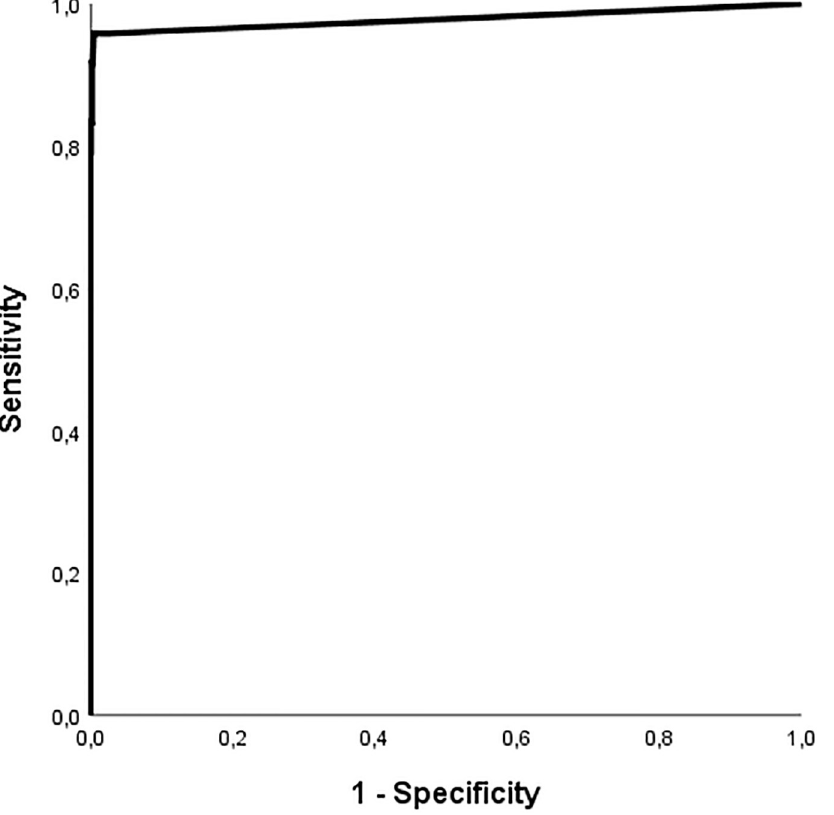
Fig 2. ROC curve of cut-off levels of mNGS normalized reads.